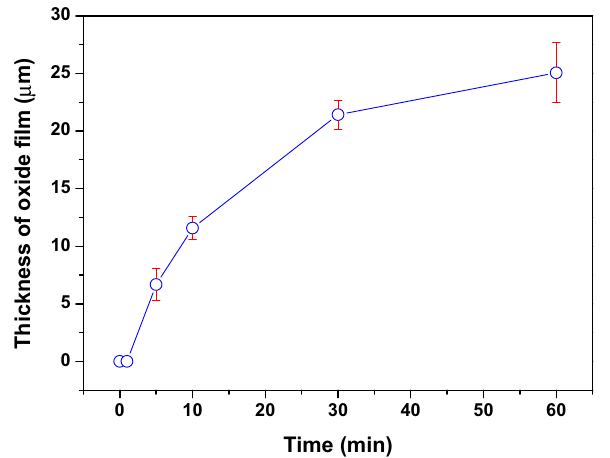
Figure 4. Thickness of the oxide film formed on the surface of the TiZr alloy as a function of heat treatment time.